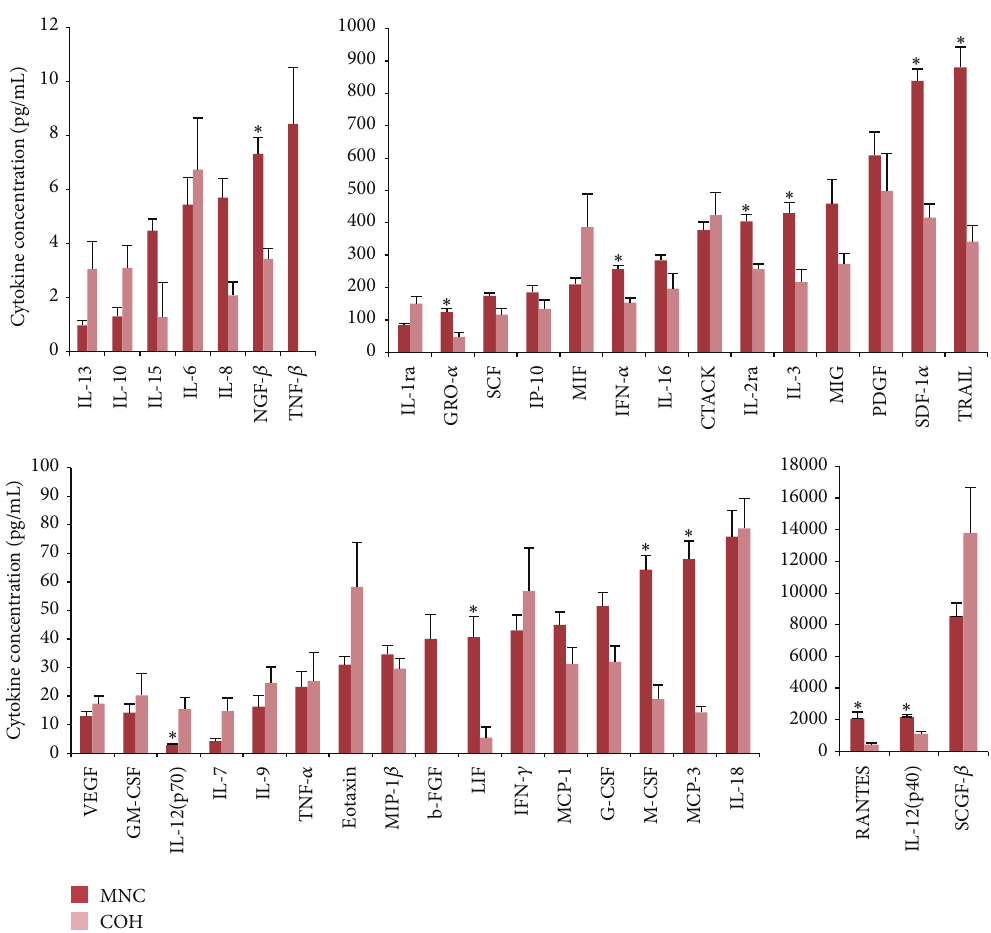
Figure 2: Mean ( ± SEM) plasma cytokine concentrations in MNC ( 𝑛 = 9 ) and COH ( 𝑛 = 10 ) cycles ( ∗ significant difference from COH cycle; 𝑃 < 0.05